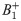
Transmit field maps.(a) Axial slices showing simulated (L) and measured (R) B1+ field maps in nT/V for the Visual Arc. (b) Flip angle maps (in degrees) of the Visual Arc (L) and Nova coils (R) using a spherical phantom (represented by the black circle).